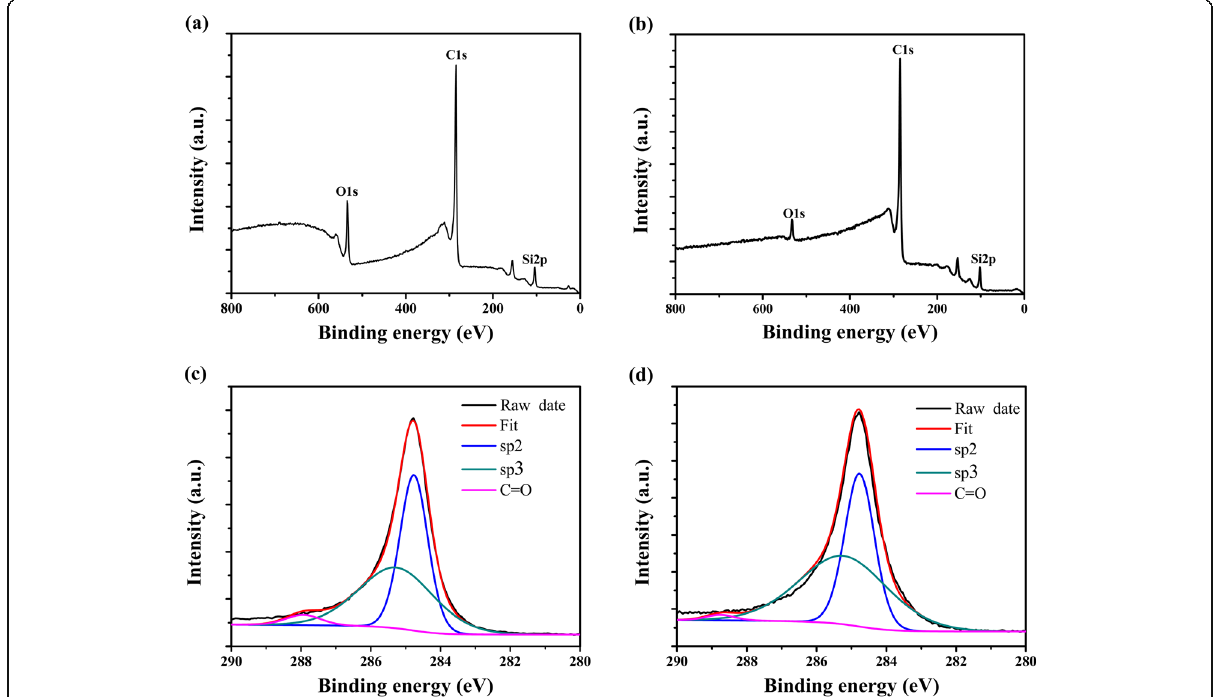
Fig. 5 XPS spectra of graphene dendrites grown on SiO 2 ( a ) and Si ( b ) surface of the SiO 2 /Si substrates. Curve fit of C1s peak of graphene dendrites grown on SiO